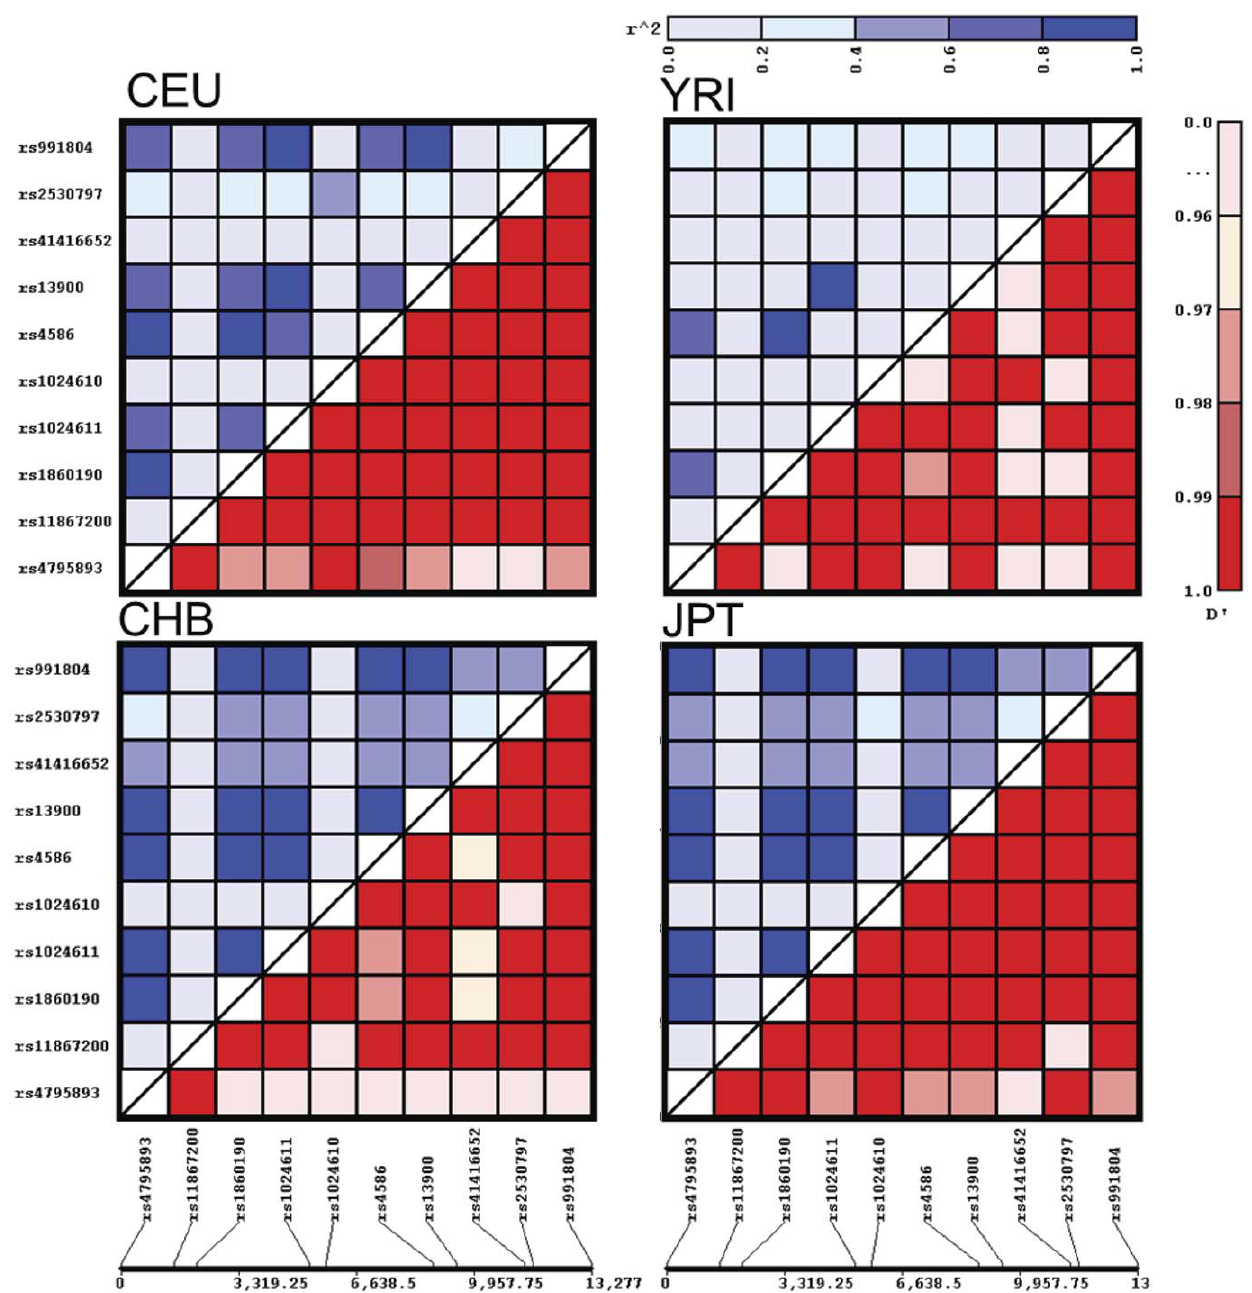
Figure 1. Linkage disequilibrium plots for the shared polymorphisms in the CCL2 locus. In all, 9 different polymorphisms that are located within a 25 kb region that spans the rs1024611 polymorphism are shown. The heatmaps display pairwise r 2 (above diagonal) or D’ (below diagonal) for the each pair of polymorphisms. The relative physical distance between the markers is shown in the bottom of the plots. Populations shown are Yoruba in Ibadan, Nigeria (YRI), Japanese in Tokyo, Japan (JPT), Han Chinese in Beijing, China (CHB) and CEPH (Utah residents with ancestry from northern and western Europe, CEU) populations (HapMap data release # 28 August 2010 on Build 36). Only unrelated individuals were used for the analysis. LD maps were constructed using the JLIN program